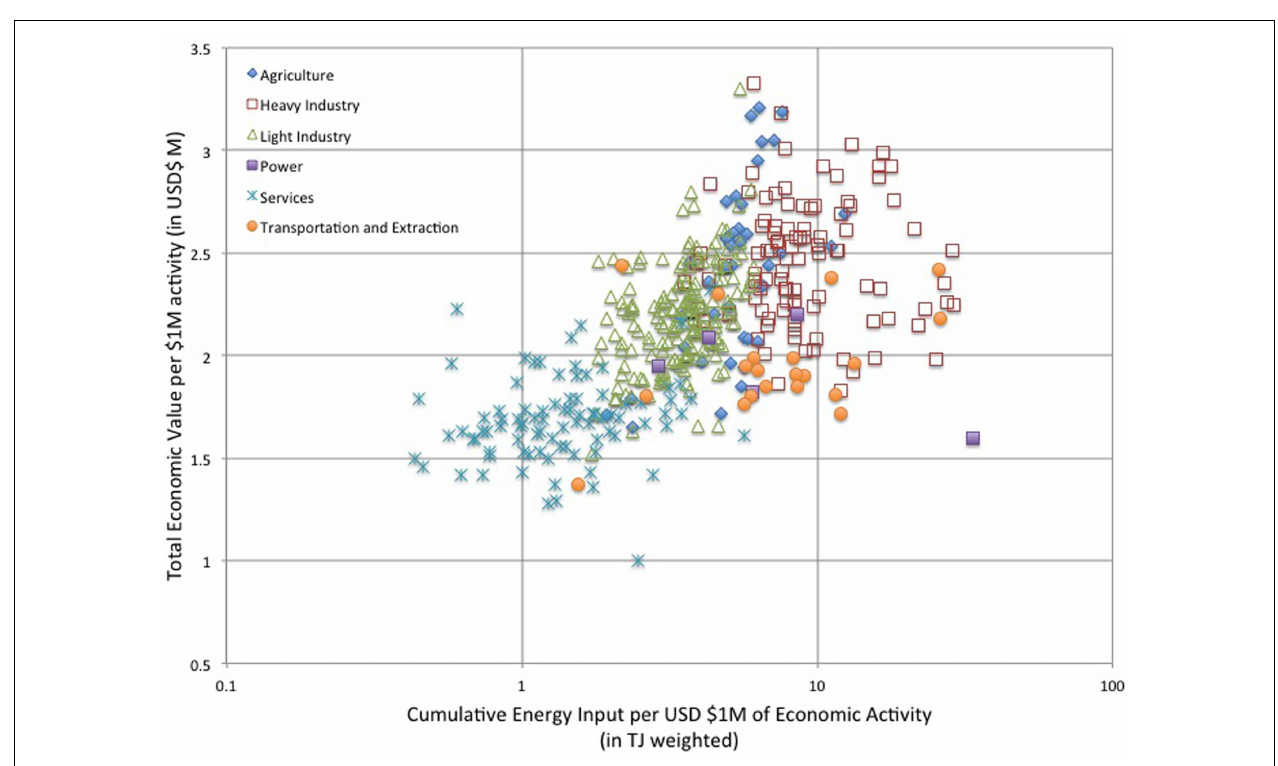
FIGURE 2 | Lifecycle correlation between economic value-added and energy input